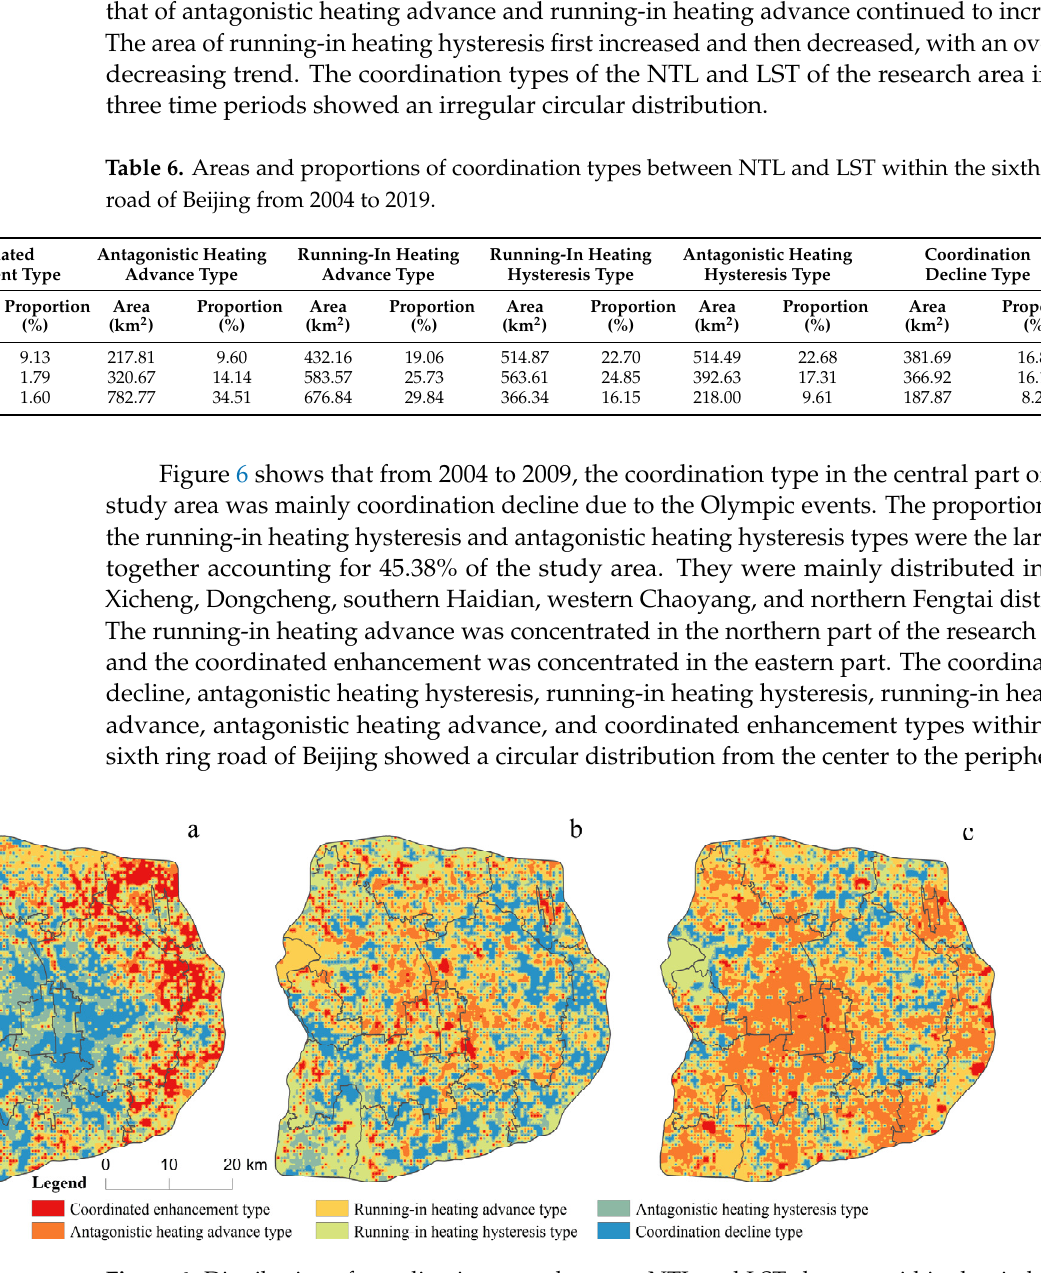
Figure 6. Distribution of coordination types between NTL and LST changes within the sixth ring road of Beijing from: ( a ) 2004 to 2009, ( b ) 2009 to 2014, ( c ) 2014 to 2019.